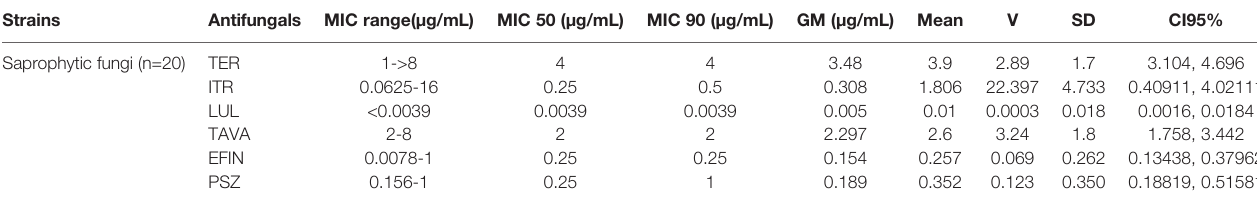
TABLE 6 | The geometric mean, MIC ranges, MIC50 and MIC90 values obtained by testing the susceptibility of saprophytic fungi to each antifungal agent. Strains